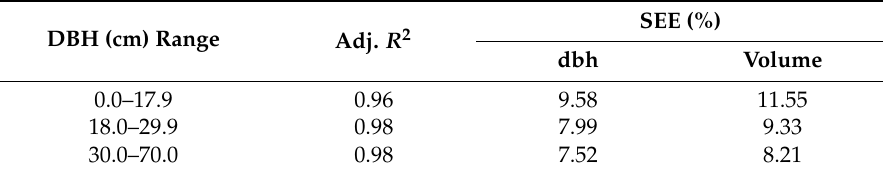
Table 1. Statistics of the taper models.